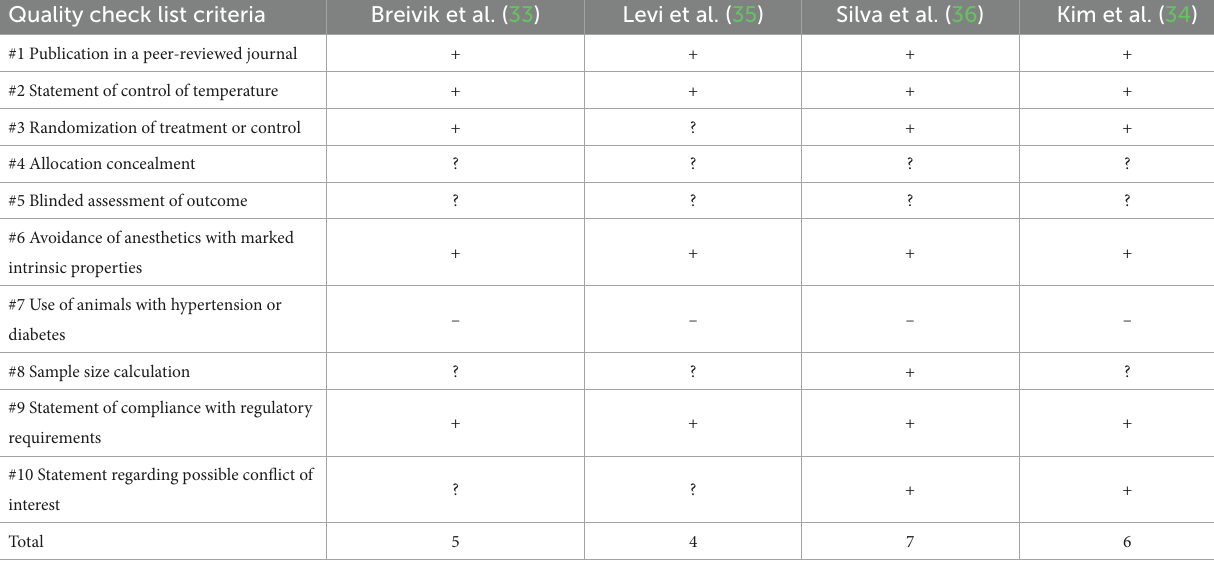
TABLE 3 Reporting quality checklist as assessed by CAMARADES, adapted from Auboire et al. (31) and Macleod et al.